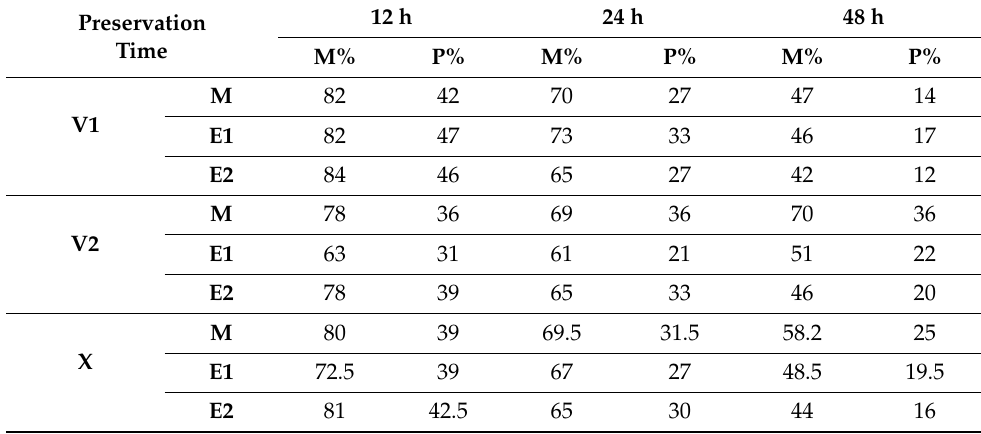
Table 6. Testing semen extenders added with fluconazole by determining sperm progressivity in storage